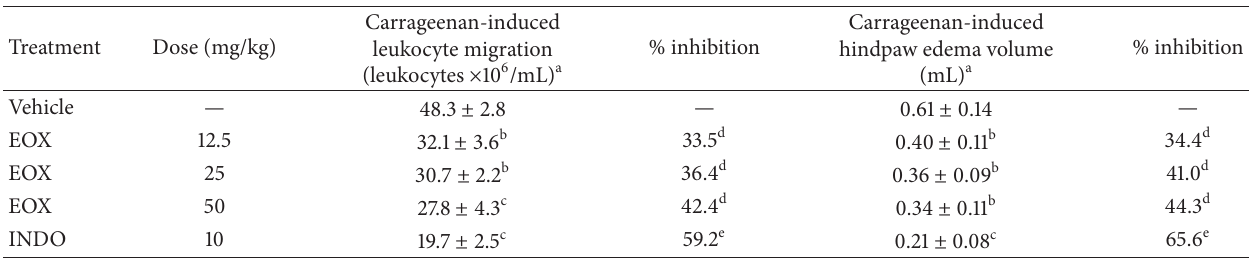
Table 4: Effect of X. laevigata leaf essential oil (EOX) or indomethacin (INDO) on carrageenan-induced leukocyte migration and carrageenan-induced hindpaw edema in